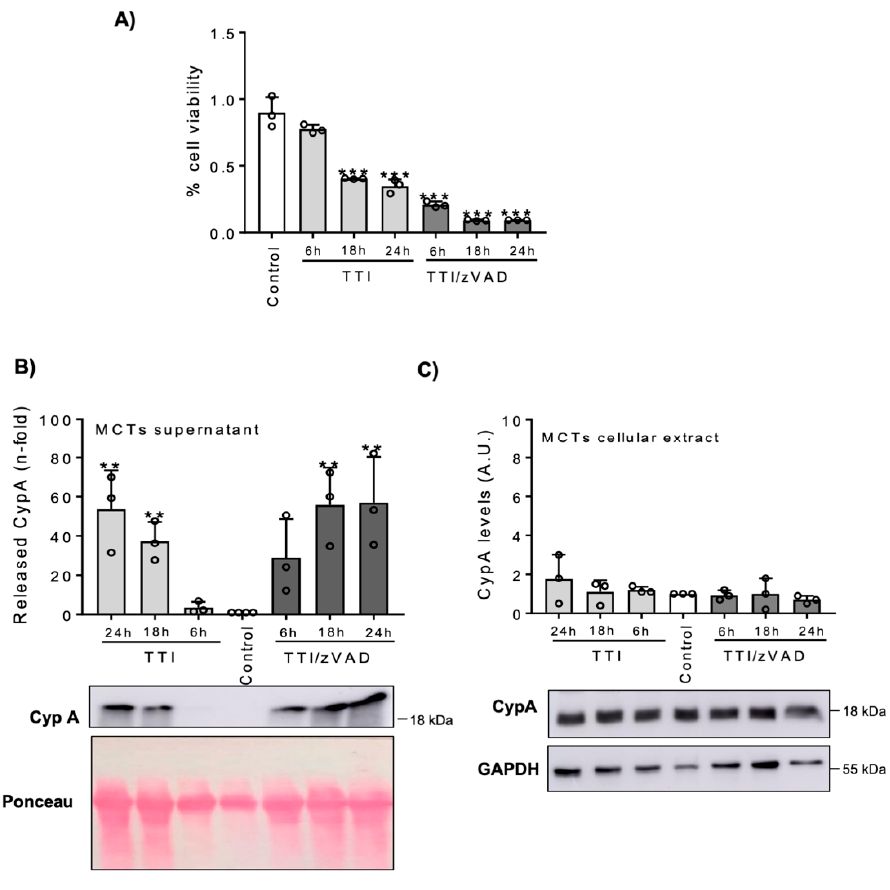
Figure 4. MCT cells were exposed to the apoptosis inducer cytokine cocktail TWEAK/TNF α /interferon- γ (TTI) or to the necroptosis inducer TTI/zVAD for the indicated periods of time. ( A ) Cell viability was assessed by the MTT assay. Mean ± SD of three independent experiments. *** p < 0.001 vs. control. ( B , C ) Western blot of CypA in cell supernatants ( B ) and in cellular extracts ( C ). Note than controls are in the middle of the gel and the time course is represented from there, i.e., later time points for both stimuli are at opposite sites of the gel and figure. Quantification and representative image. Mean ± SD of three independent experiments. ** p < 0.01 vs. control. Uncropped gel scans shown in Figure S2B.